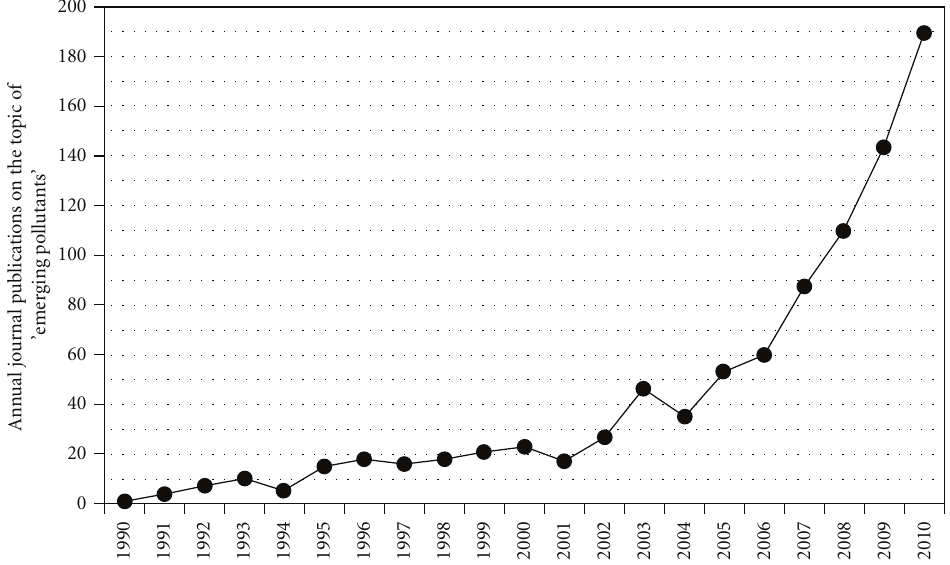
FIGURE 2: The annual number of peer-reviewed journal articles published under the topic of “emerging pollutants” from 1990 to 2010, adapted from